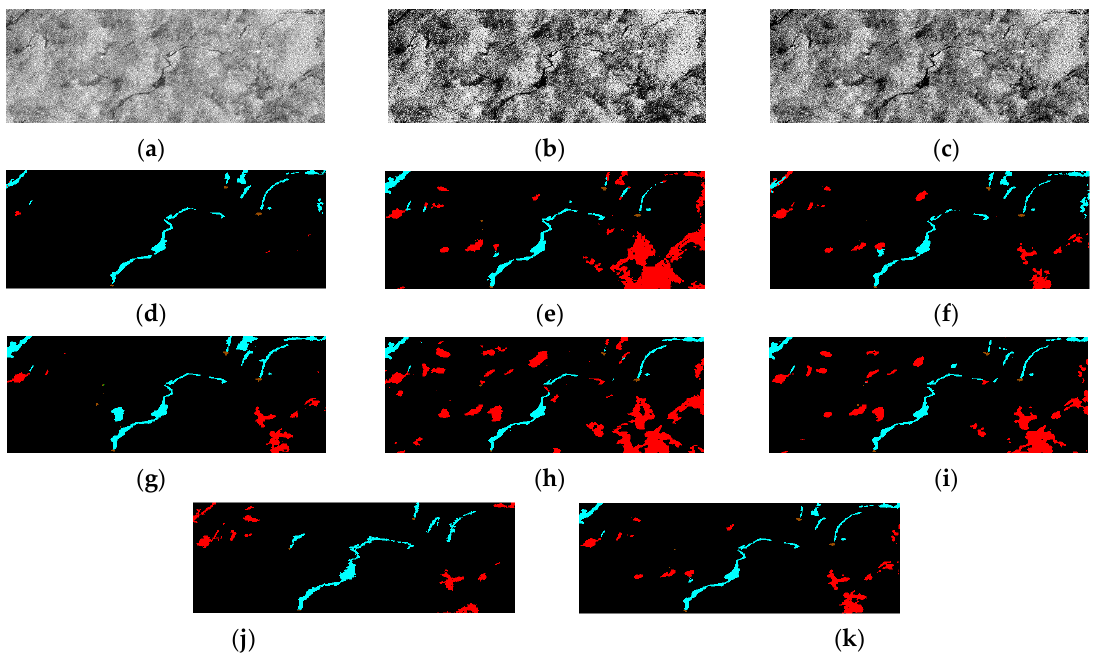
Figure 12. Example 3 of the different predictions created by the models: ( a ) original image; ( b ) image with histogram equalization; ( c ) image with contrast stretch; ( d ) DeepLabv3+ prediction; ( e ) DeepLabv3+ with histogram equalization prediction; ( f ) DeepLabv3+ with contrast stretch prediction; ( g ) Unet prediction; ( h ) Unet with histogram equalization prediction; ( i ) Unet with contrast stretch prediction; ( j ) ground truth; ( k ) ensemble model prediction.